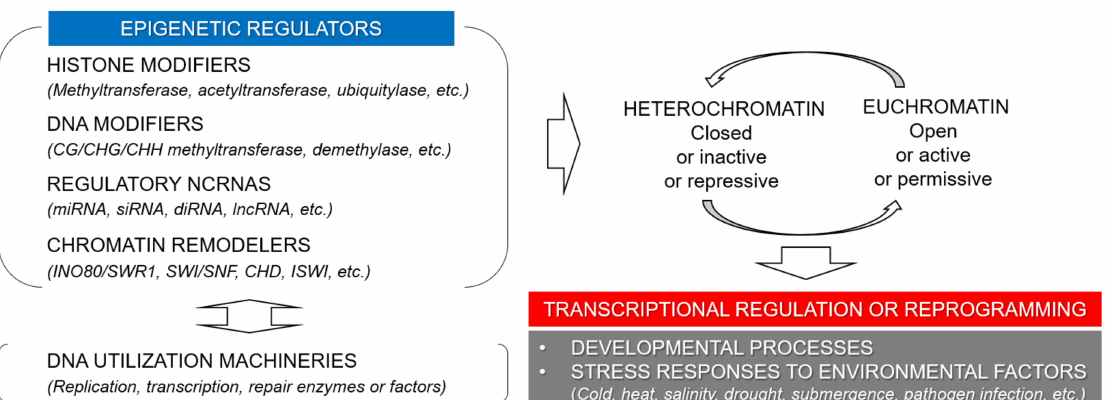
Figure 1. Epigenetic regulators mediate chromatin dynamics for transcriptional regulation or reprogramming in plant development and stress response. Histone and DNA modifiers, regulatory non-coding RNAs (ncRNAs), chromatin remodelers, and DNA utilization machineries together constitute a multilayered and multifaceted circuitry for chromatin- based transcriptional regulation in plant development and stress